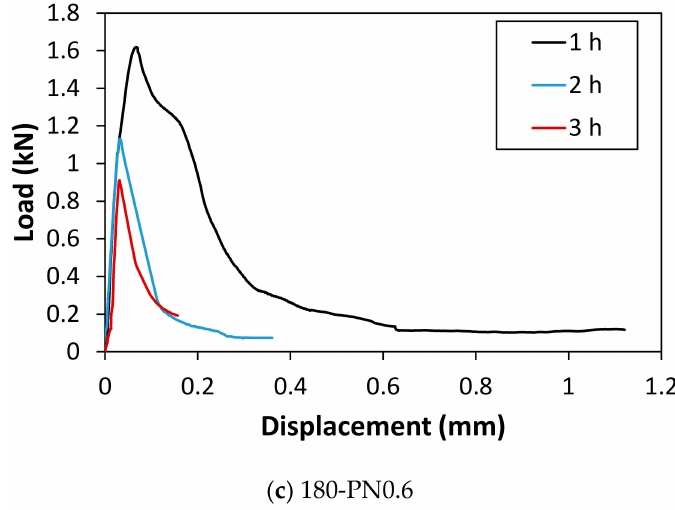
Figure A5. Residual load–displacement curves of specimens with a strength of 180 MPa according to the exposure